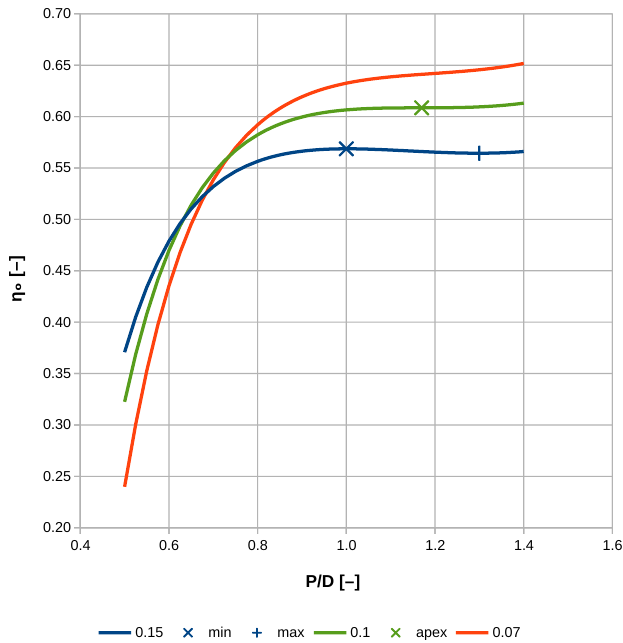
Figure 5. Run of the efficiencies versus pitch ratio P ⁄ D along the lines P D = 0.15, 0.1, and 0.07, corresponding to the region of the overlap P D | Additionally shown are the extrema for P D = 0.15 and the apex for P D |